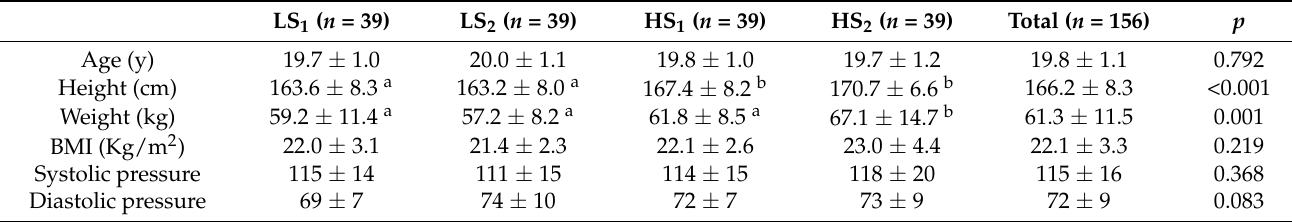
Table 1. The characteristics of